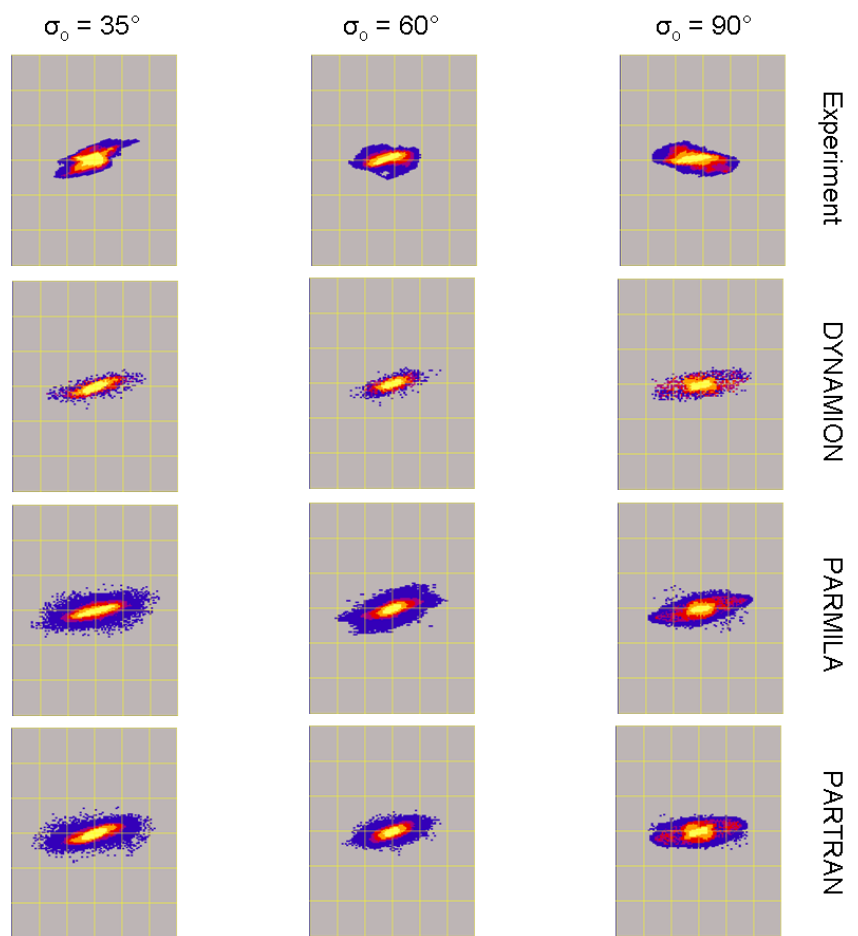
FIG. 11. (Color) From top to bottom: horizontal phase space distributions as measured and simulated at the exit of the DTL using DYNAMION , PARMILA , and PARTRAN . Left: (cid:4) o ¼ 35 (cid:1) ; center: (cid:4) o ¼ 60 (cid:1) ; right: (cid:4) o ¼ 90 (cid:1) . The scaling is (cid:4) 24 mm (horizontal axis) and (cid:4) 24 mrad (vertical axis),